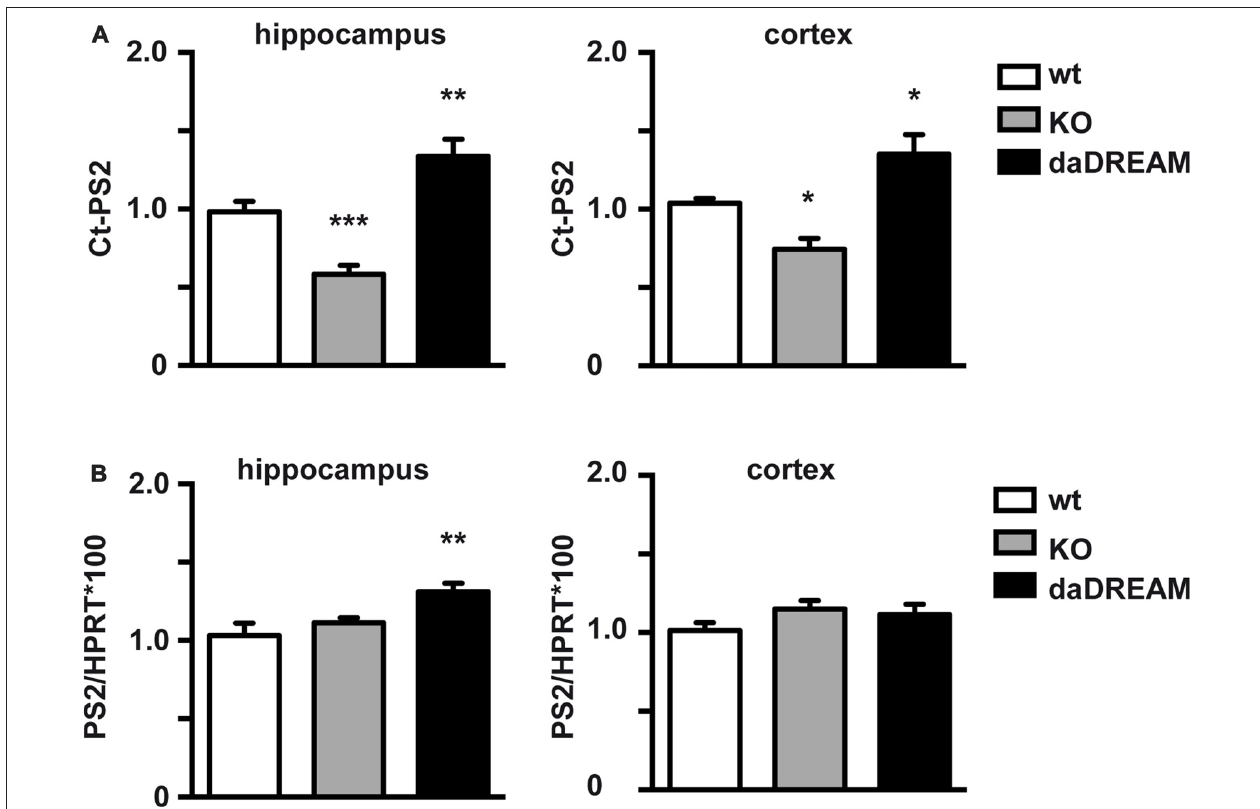
FIGURE 2 | Effect of endogenous DREAM levels on PS2 endoproteolysis and PS2 gene expression. (A) Quantified Western blots with anti-PS2 antibody of hippocampal (Hpp) and cortical (Cx) extracts from wild-type (WT), DREAM deficient knockout (KO) and transgenic mice overexpressing dominant active DREAM (daDREAM). (B) Quantitative PCR (qPCR) analysis of PS2 mRNA levels in the hippocampus and the cerebral cortex from the same three genotypes as in (A) . Ordinary one-way ANOVA with Holm-Sidak’s multiple comparison test ( n = 11, for each genotype) ∗ P < 0.05, ∗∗ P < 0.01, ∗∗∗ P <